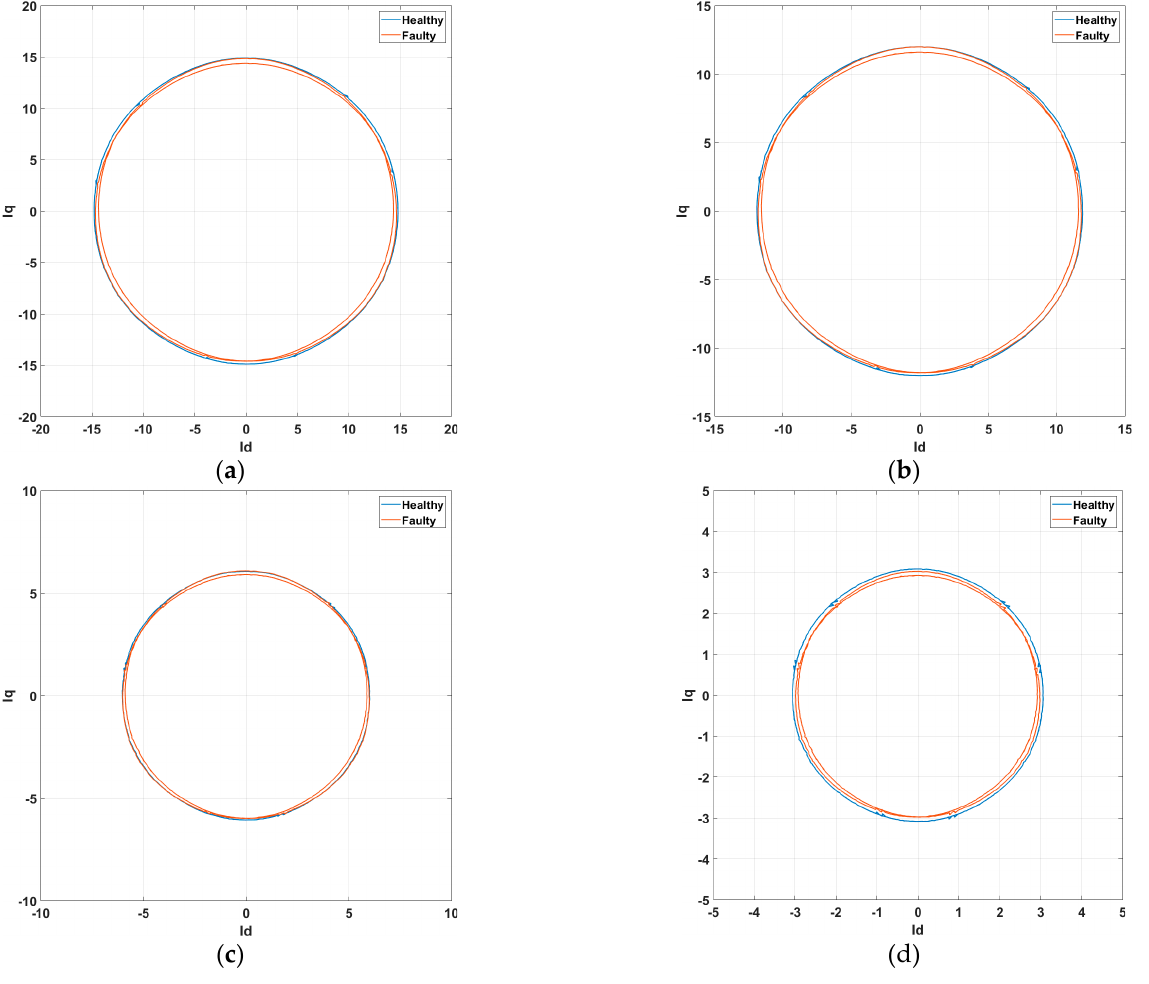
Figure A3. Simulation results. Park’s Vector of the generator at 100 rpm: ( a ) Local demagnetization